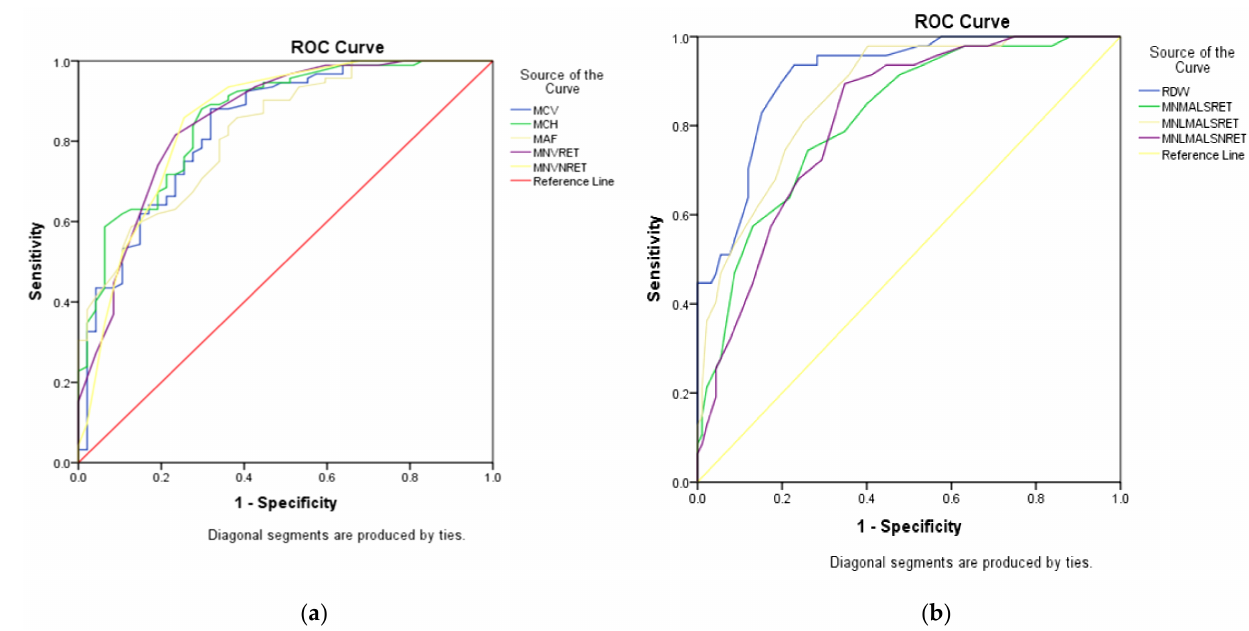
Figure 1. ( a , b ) ROC curves of RBC parameters and reticulocyte CPD to distinguish α from β thalassaemia